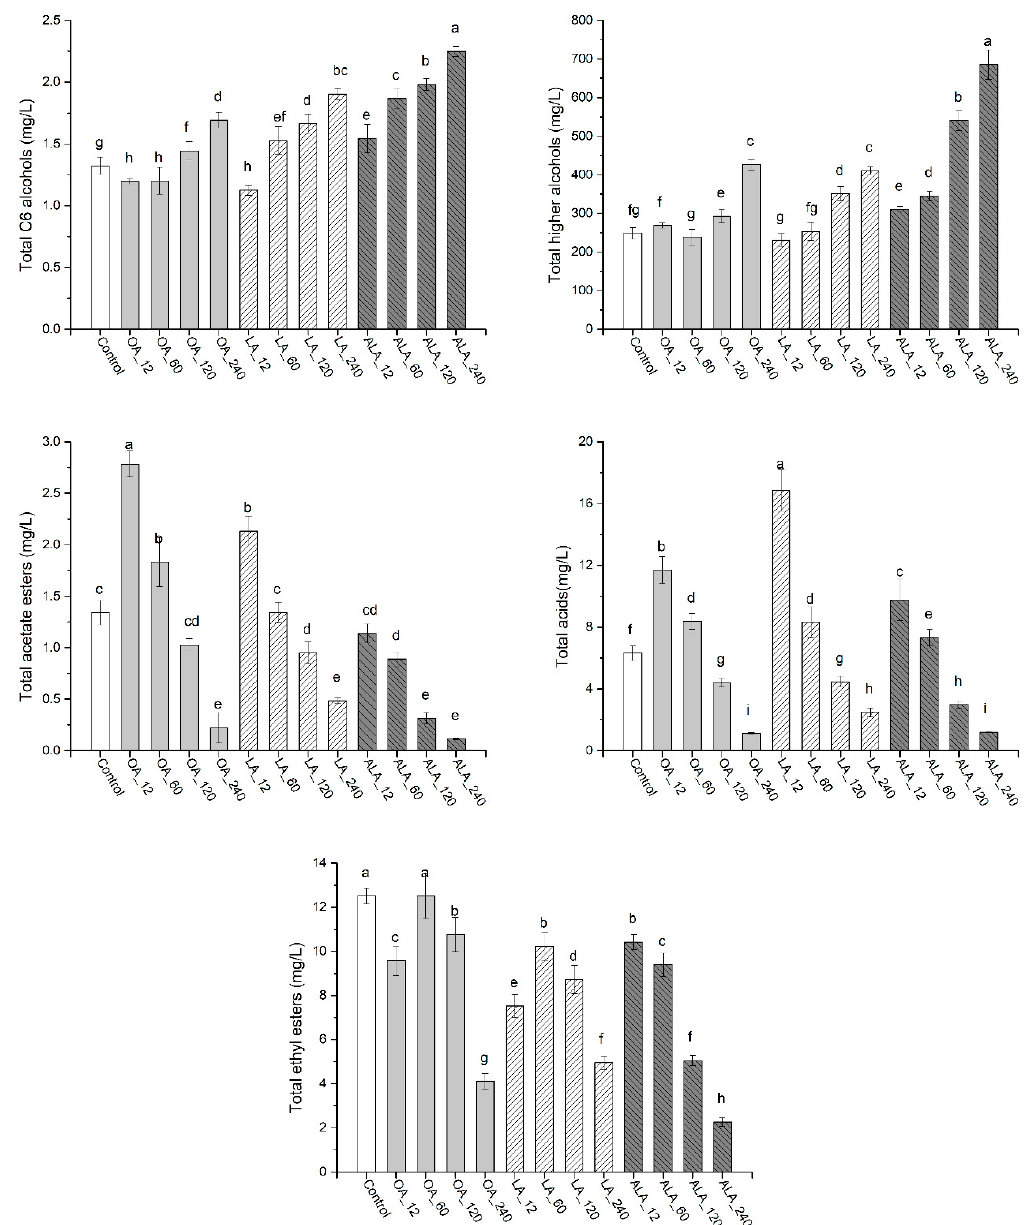
Figure 3. Total concentrations of C6 alcohols, higher alcohols, acetate esters, acids, ethyl esters, terpenes, and norisoprenoids in the final wines with different treatments. Values of the same compound marked with the same lowercase letters indicates no significant difference ( p < 0.05, Duncan’s test).